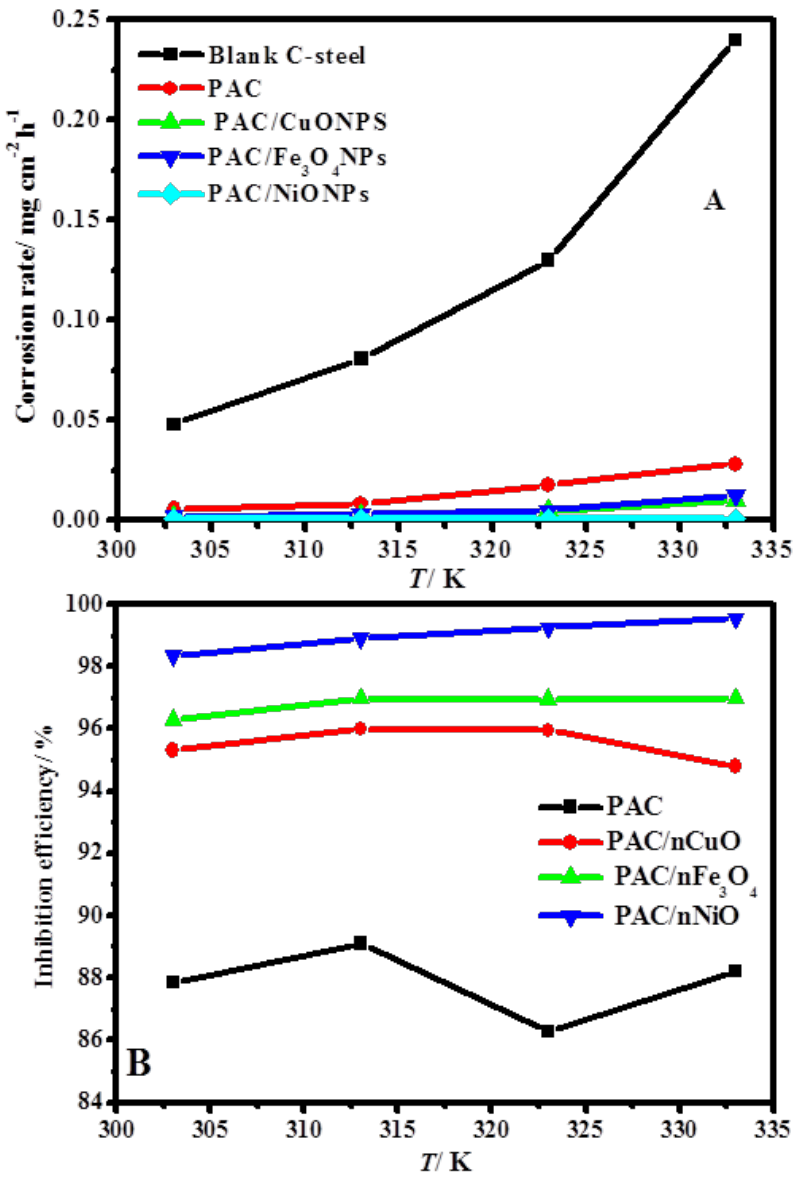
Figure 6. Corrosion rate ( A ) and inhibition efficiency ( B ) of C-steel in 1.0 M HCl solution containing 250 ppm of inhibitors at various temperatures.